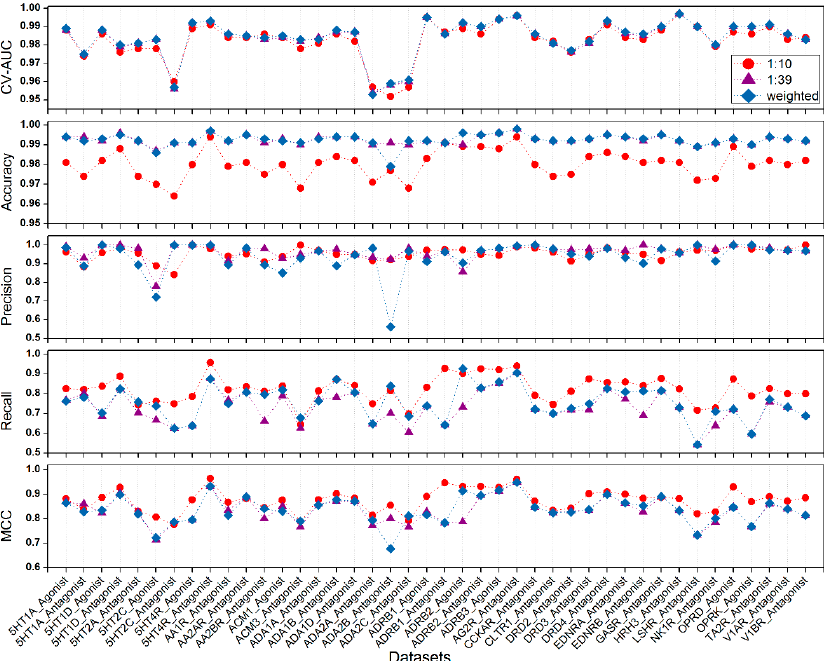
Figure 2. Comparison of the three methods in handling the data imbalance. The red circle denotes model results based on data sets with the proportion of 1:10 (ligands:decoys). The purple triangle denotes model results based on data sets with the original ratio (1:39). The blue diamond denotes results of models with different weight for ligands class and decoys class in the SVM model training.